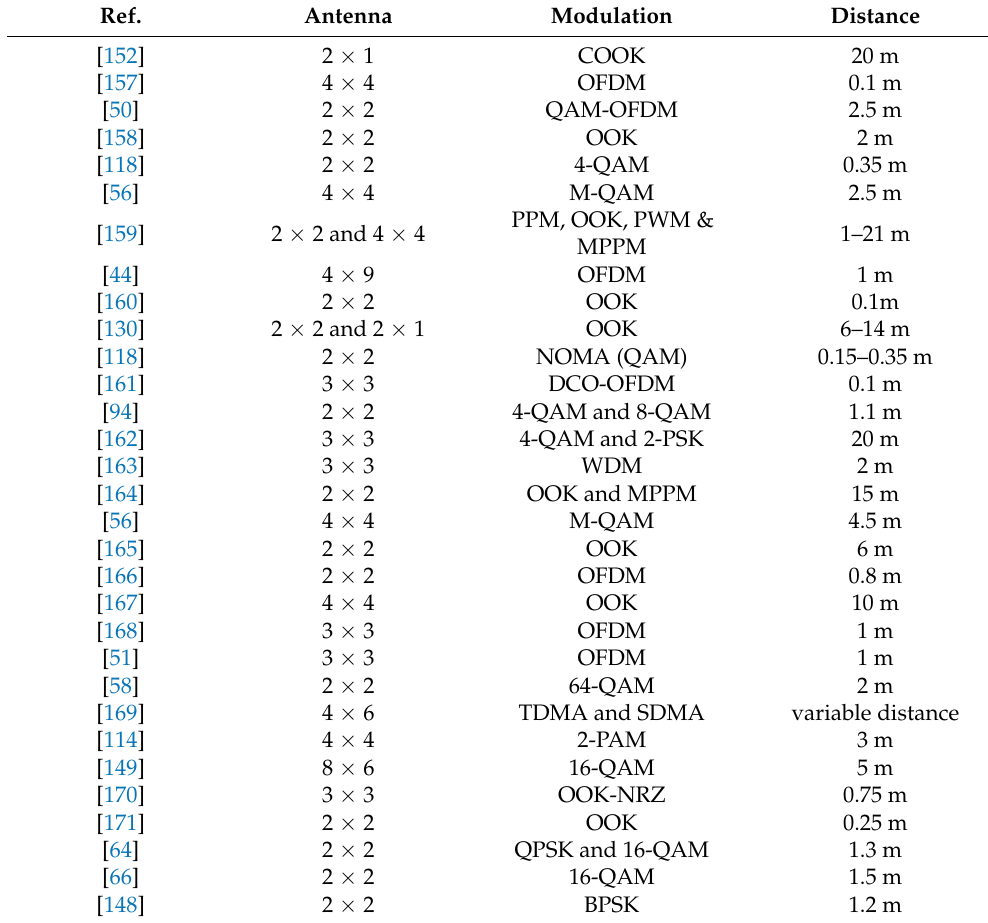
Table 3. Experimental Study on MIMO VLC Communication.